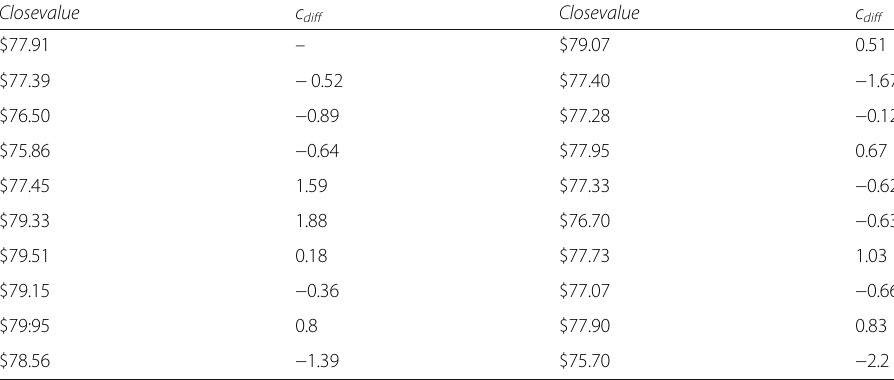
Table 4 IBM stock close value dataset